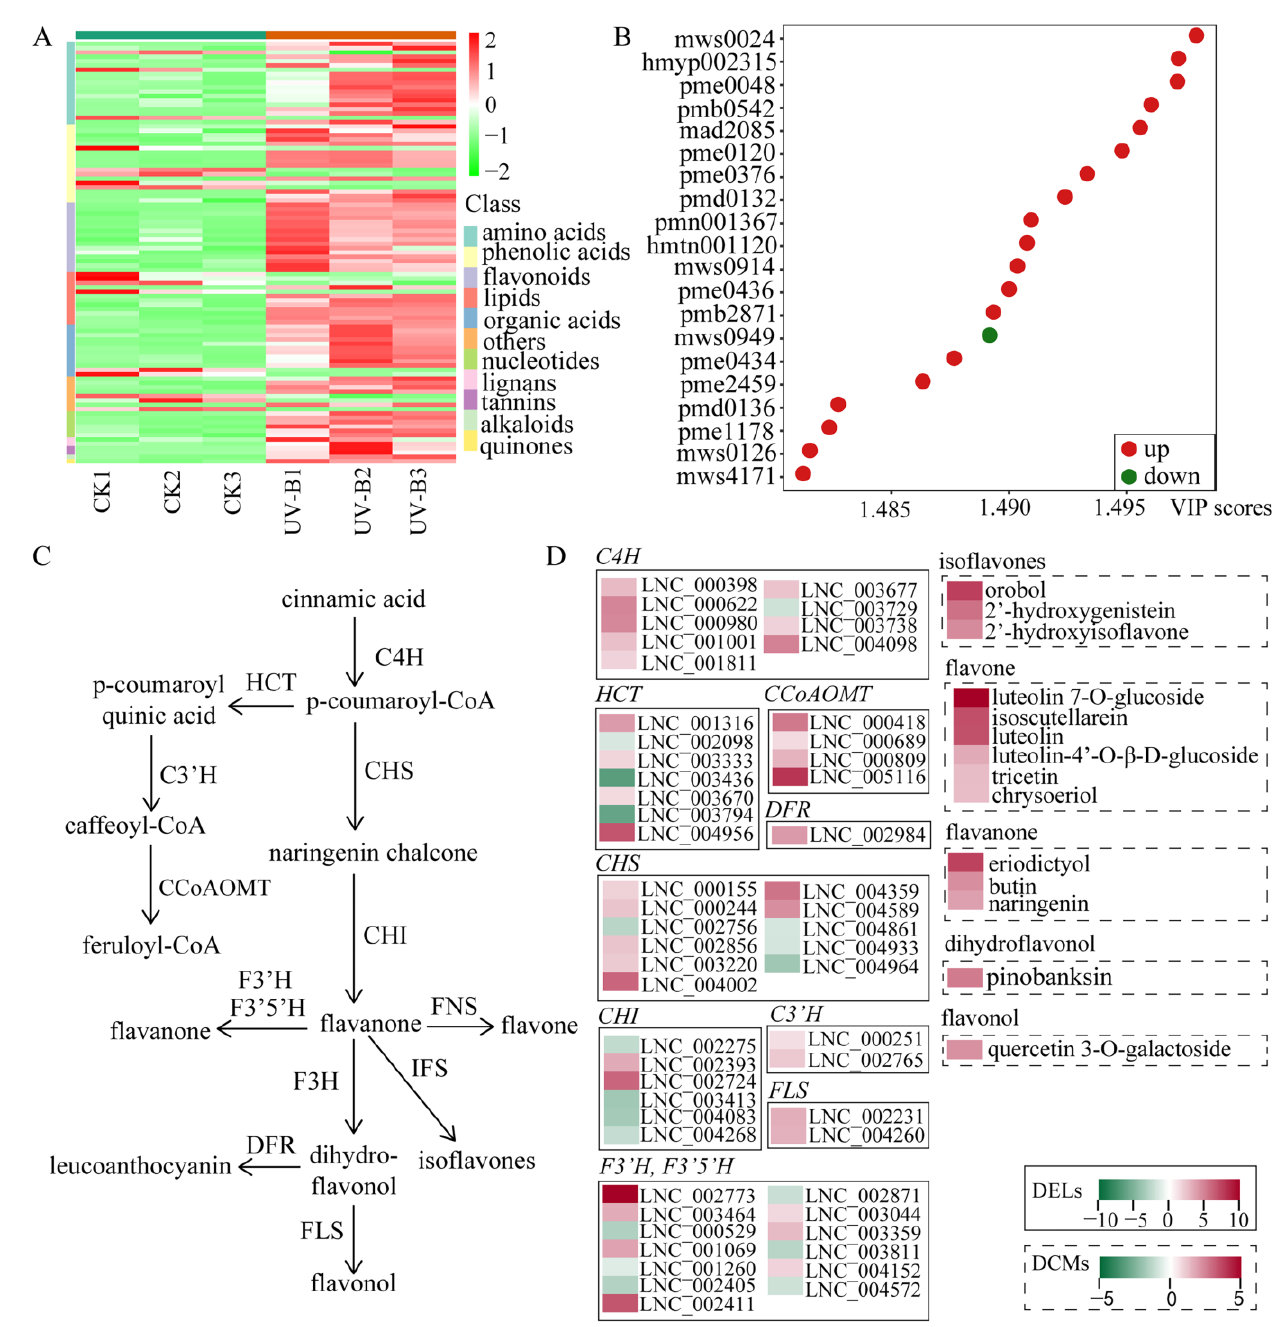
Figure 5. Integrated analyses of transcriptome and metabolome of flavonoid synthesis pathway under UV-B radiation. ( A ) Heatmap of differentially changed metabolites (DCMs) sorted by metabolite classes in Pohlia nutans after 3 d of UV-B treatment. ( B ) The VIP scores of the top 20 DCMs between the two groups. ( C ) Integrated transcriptome and metabolome analyses showed that flavonoid biosynthesis might contribute the resistance of P. nutans against UV-B radiation. ( D ) The block of each DEL and DCM indicated the log 2 (foldchange) of this DEL and DCM between the control group and the UV-B group. DELs labeled in solid line box and DCMs showed in dotted box.